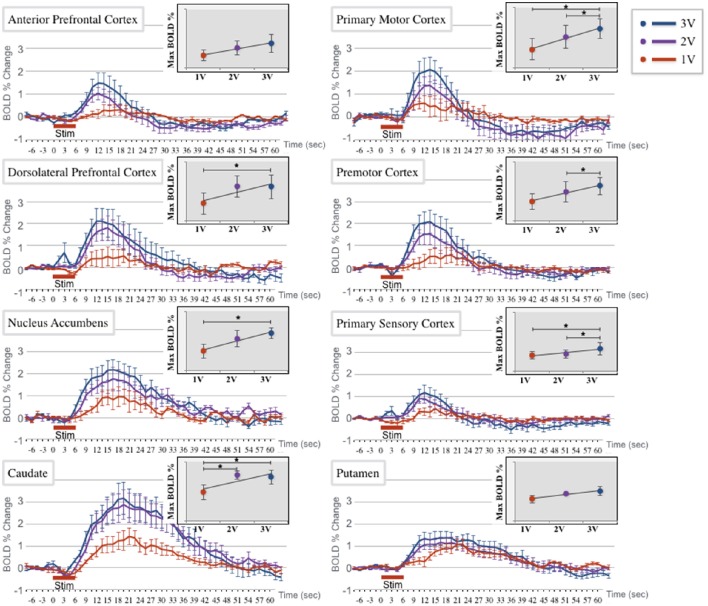
BOLD % change time course at 1, 2, and 3 V stimulation amplitude (red, purple, and blue, respectively) at each of 8 regions of interest (ROI): anterior prefrontal cortex (APFC), primary motor cortex (PIMC), dorsolateral prefrontal cortex (DLPFC), premotor cortex (PEMC), nucleus accumbens (NAc), primary somatosensory cortex (PSSC), caudate (Cd), and putamen (PT). Each amplitude is presented as the average (± standard error) across the 3 subjects in each region of interest (ROI). Insert: The inset graph demonstrates a linear regression of the peak value at each of the three amplitudes, with significant differences denoted with a star (*). The APFC, DLPFC, PEMC, NAc, and Cd all had significant differences in BOLD percent change between 1 and 3 V amplitudes. APFC also showed a significant difference between the 2 and 3 V amplitudes. PIMC, PSSC, and PT showed no significance between any of the three amplitudes.